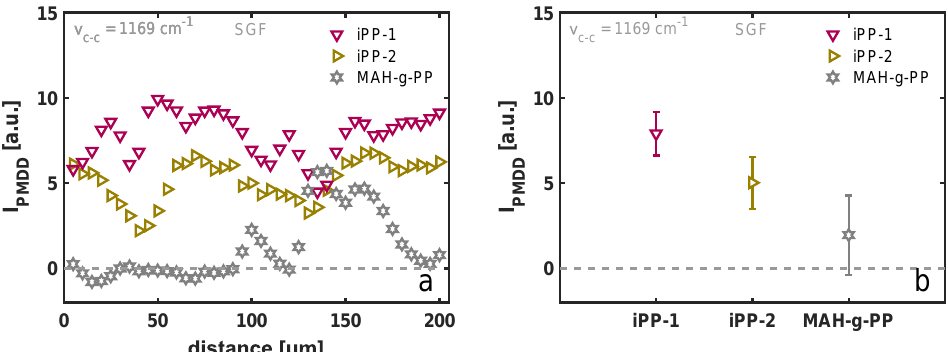
Figure 7. Intensity of the polarization-modulated dichroic difference as ( a ) a function of sample position corresponding to the lines indicated in Figure 6a and ( b ) averaged over a length of 200 µ m with the error bars indicating the variation of the signal with position, as can be deduced from ( a